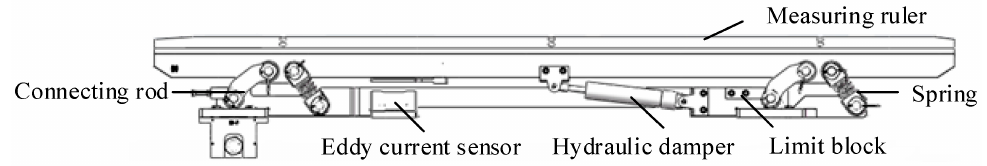
Figure 5. A schematic diagram of the parallelogram mechanism [73].